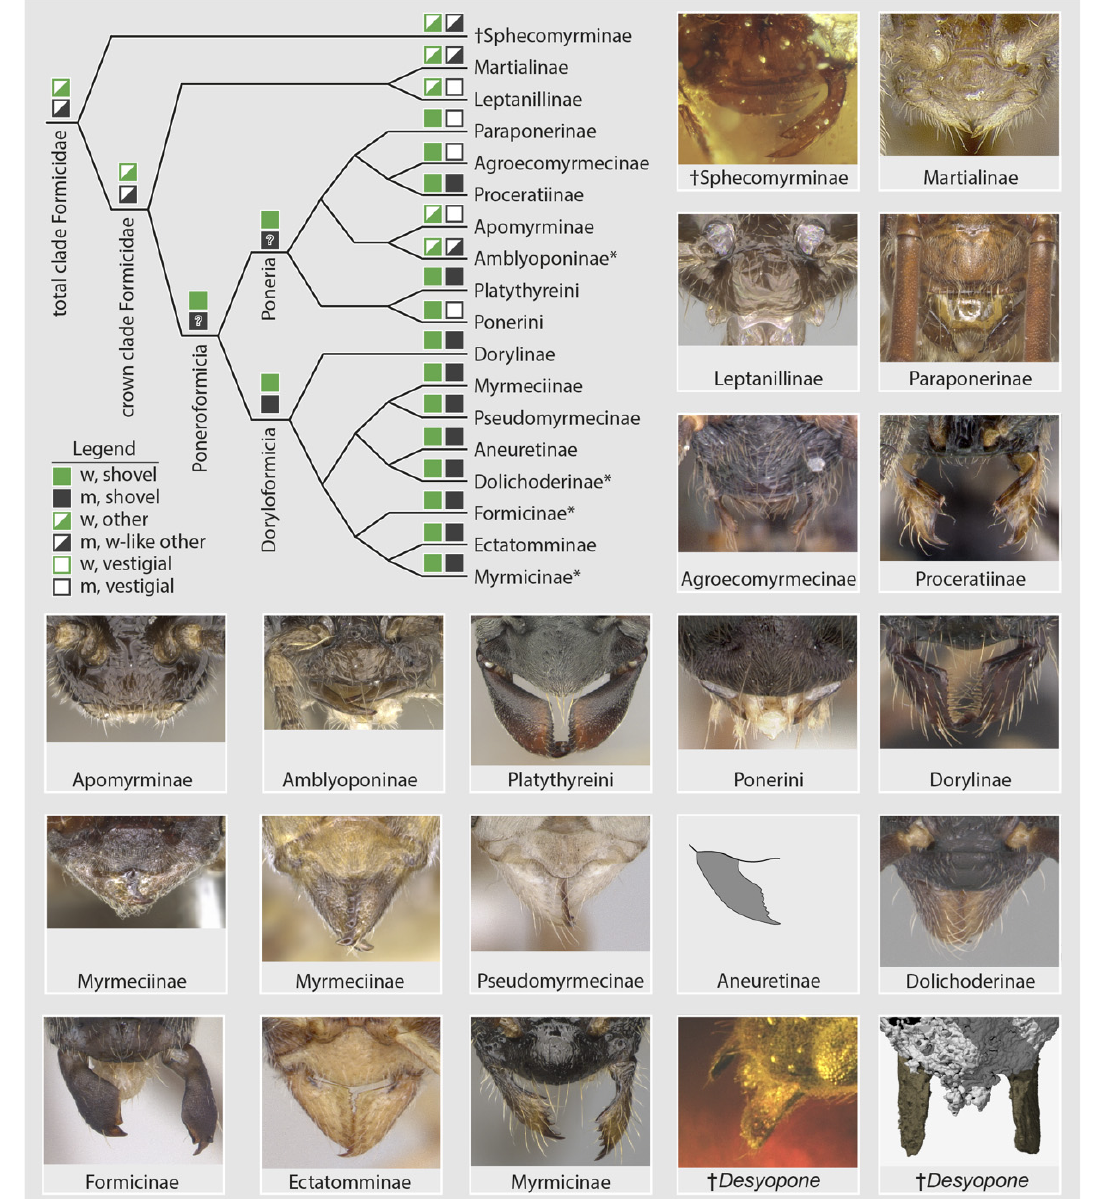
Figure 6. Diagrammatic summary of male mandibular development across the Formicidae at subfamily level. Subfamilies with asterisks (*) have genera or genus groups which are diagnosable by male mandibular vestigiality. In the legend, “w” = worker/female, “m” = male. Images from the top left to the bottom right are from AntWeb [30] with the exception of the Aneuretinae (after [51]) and the † Desyopone (this study): †Sphecomyrminae (ANTWEB1032637, J. Chaul), Martialis (ANT ‐